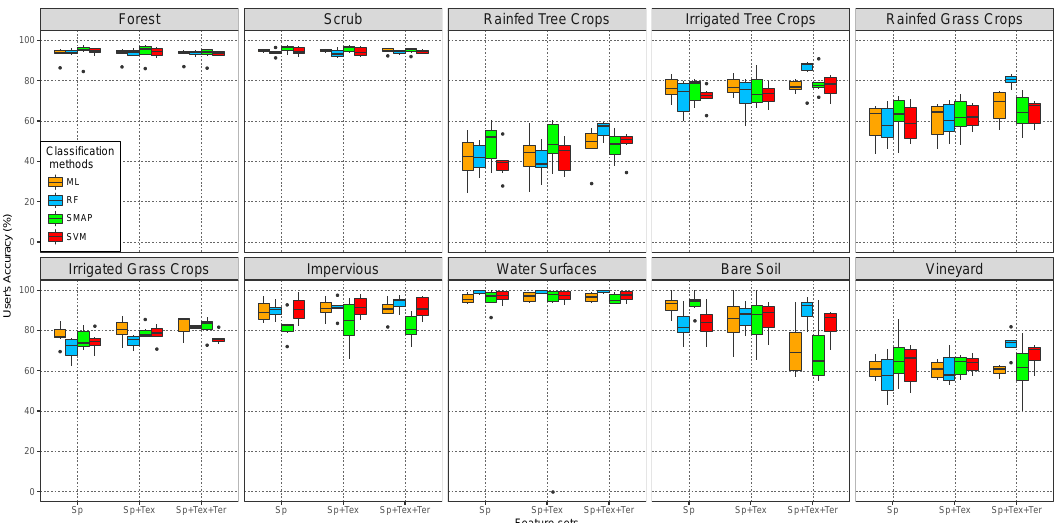
Figure 9. Per class user’s average accuracy values (user’s and producer’s) using four season imagery. Number of classifications: 72. Sp: Spectral features; Tx: Textural features; Tr: Terrain